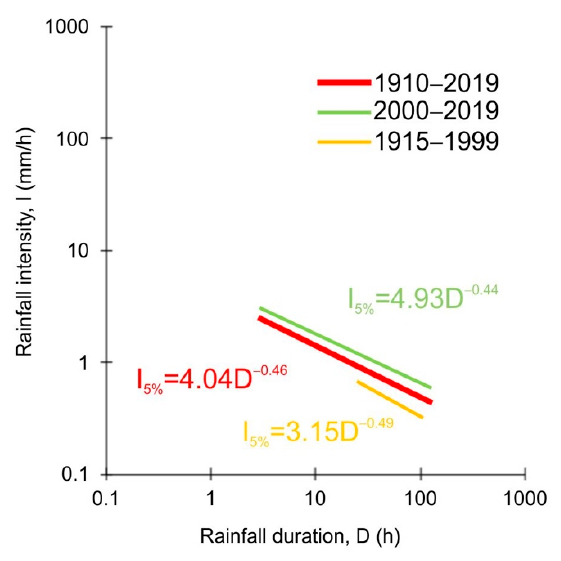
Figure 14. Comparison between the rainfall threshold established for different periods, from the past to the present: 1910–1999 (yellow curve), 2000–2019 (green curve), and 1910–2019 (red curve).